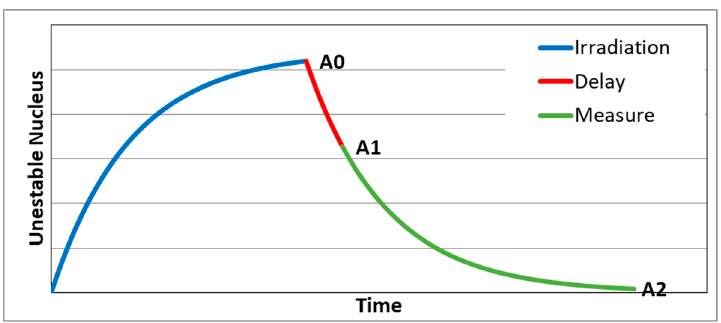
Figure 1. Evolution of number of unstable atoms over time.